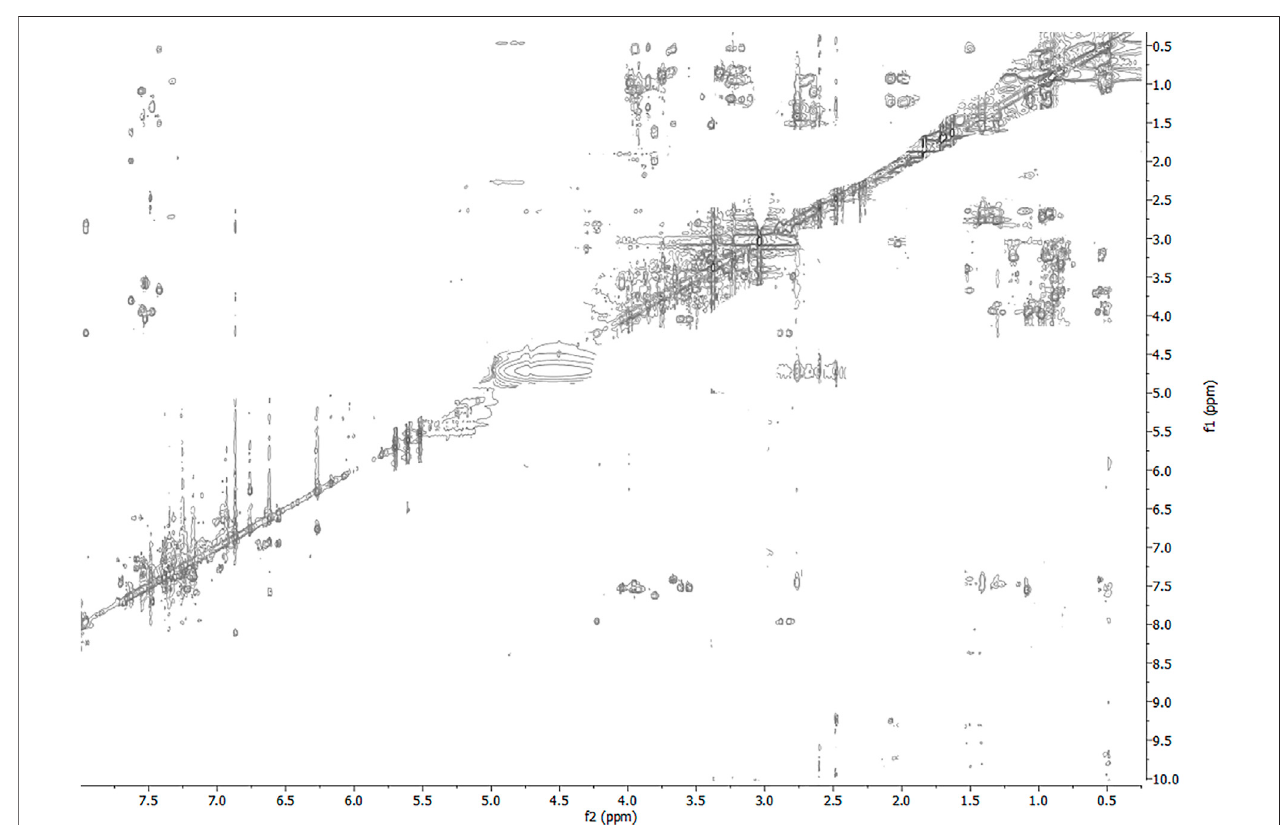
FIGURE 6 | 2D-TOCSY spectrum of 3 HFA/H 2 O solution (600 MHz, 300 K, t mix (cid:2) 80 ms).